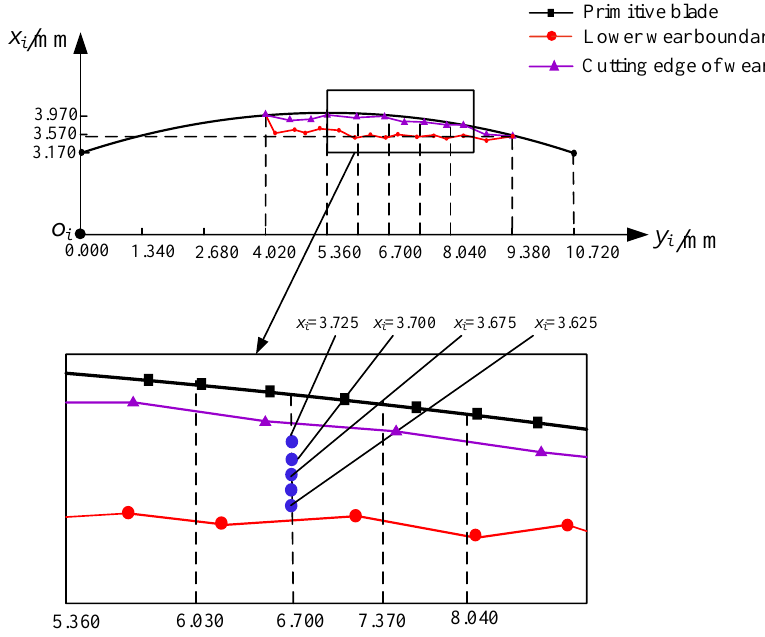
Figure 3. Instantaneous wear boundary of cutter tooth 1. From Equations (4)–(9), the instantaneous wear volume growth rate, V i ( t ), and the accumulated wear volume, Σ V i , at the friction contact points within the friction wear boundaries are: